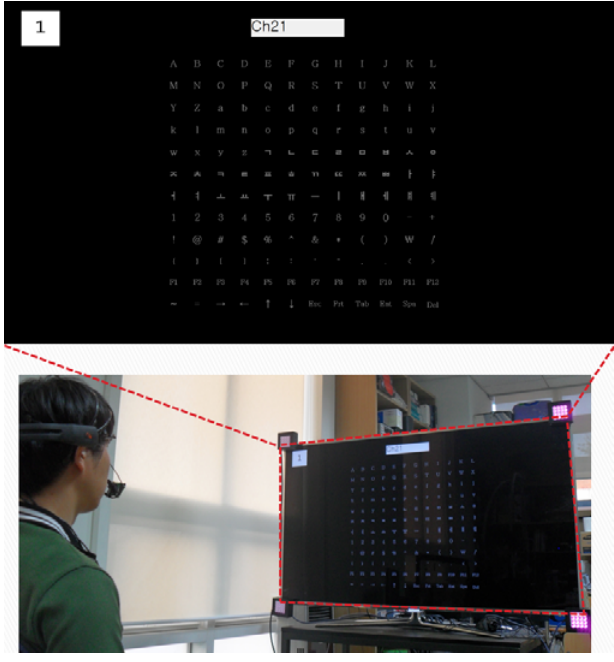
Figure 11. Example of the channel controller of smart TV using the proposed method.